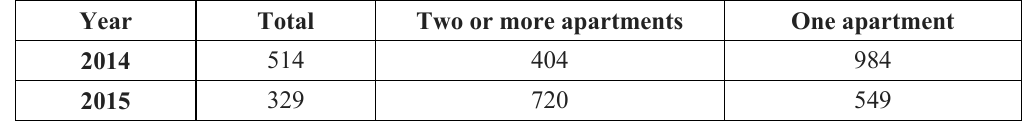
Table 2 . New Residential Buildings (thousand sq.